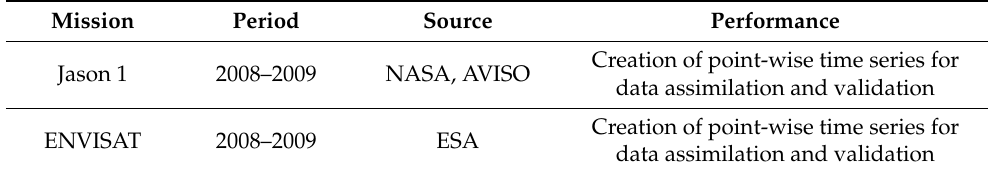
Table 3. Specifications of satellite altimetry data.